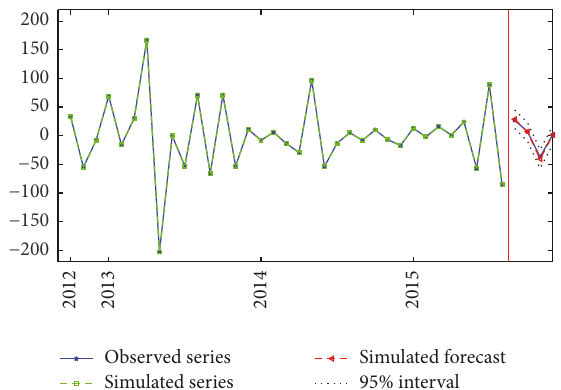
Figure 7: The actual, fitted, and forecasted series by hybrid model for series of deaths.